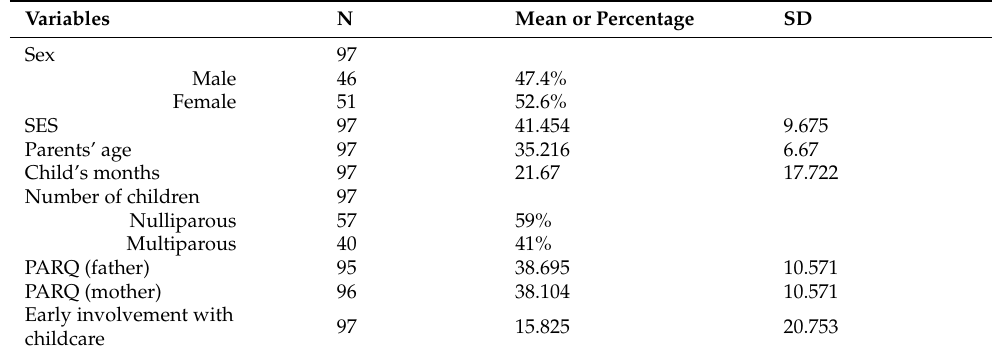
Table 1. A broad overview of the characteristics of parents. N = number; SD = standard